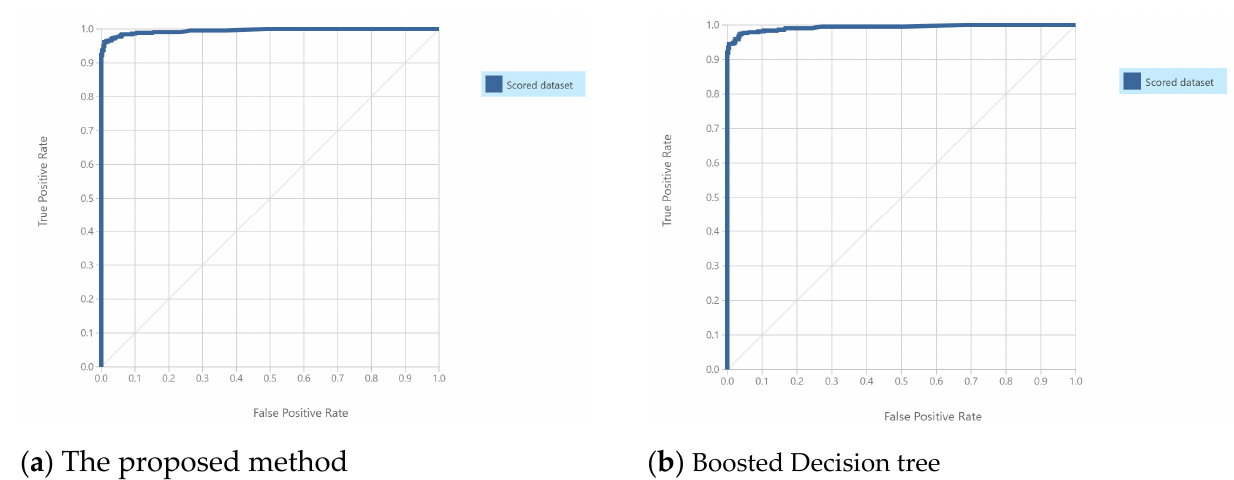
Table 6. Results of blister packing machine case.